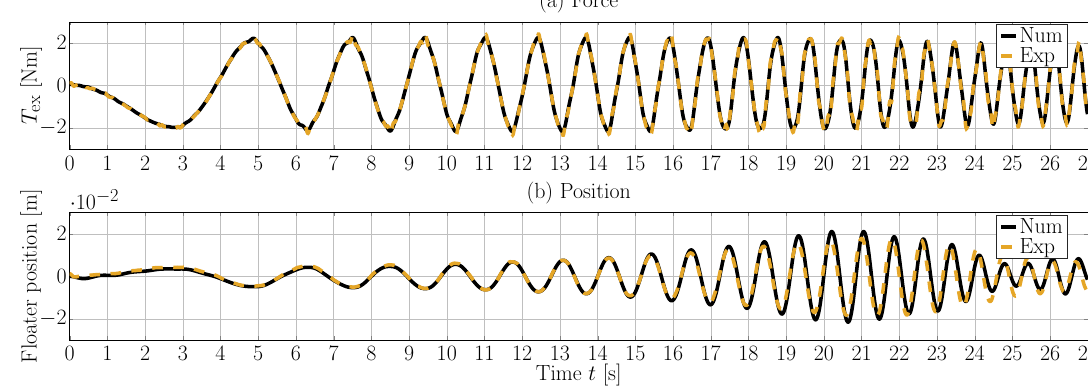
Figure 19. Time trace of the multi-frequency excitation torque ( a ) and the floater position ( b ).